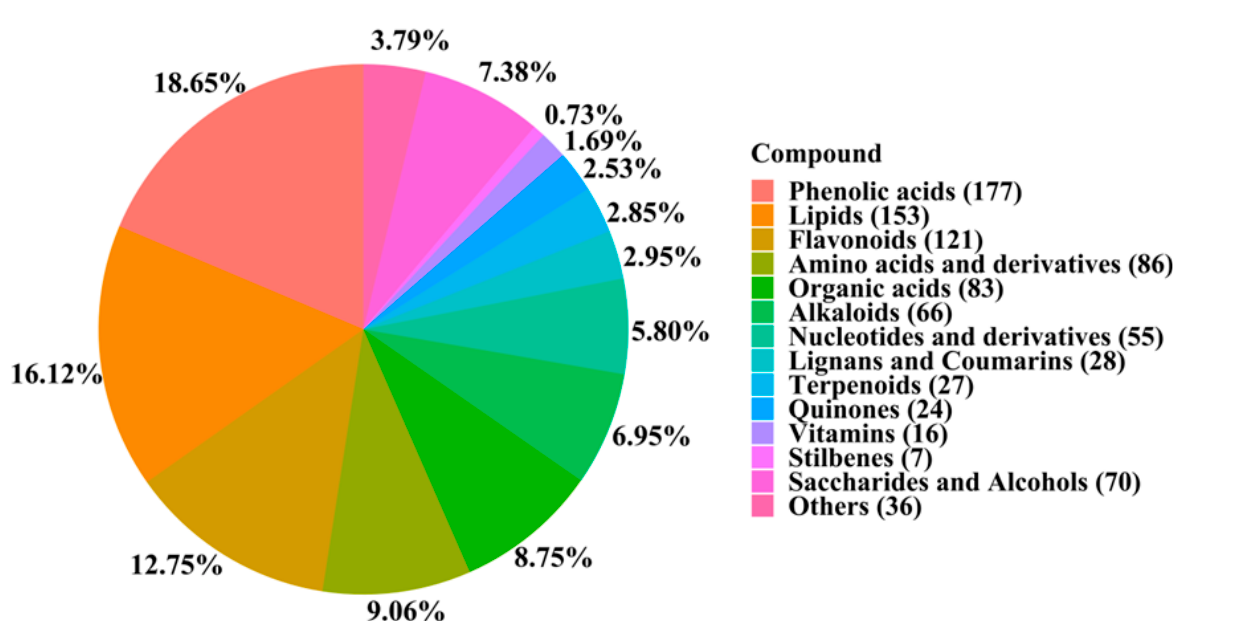
Figure 2. The classification and of the metabolites. This pie chart depicts the proportion of different types of metabolites among the metabolites detected by UPLC-MS.